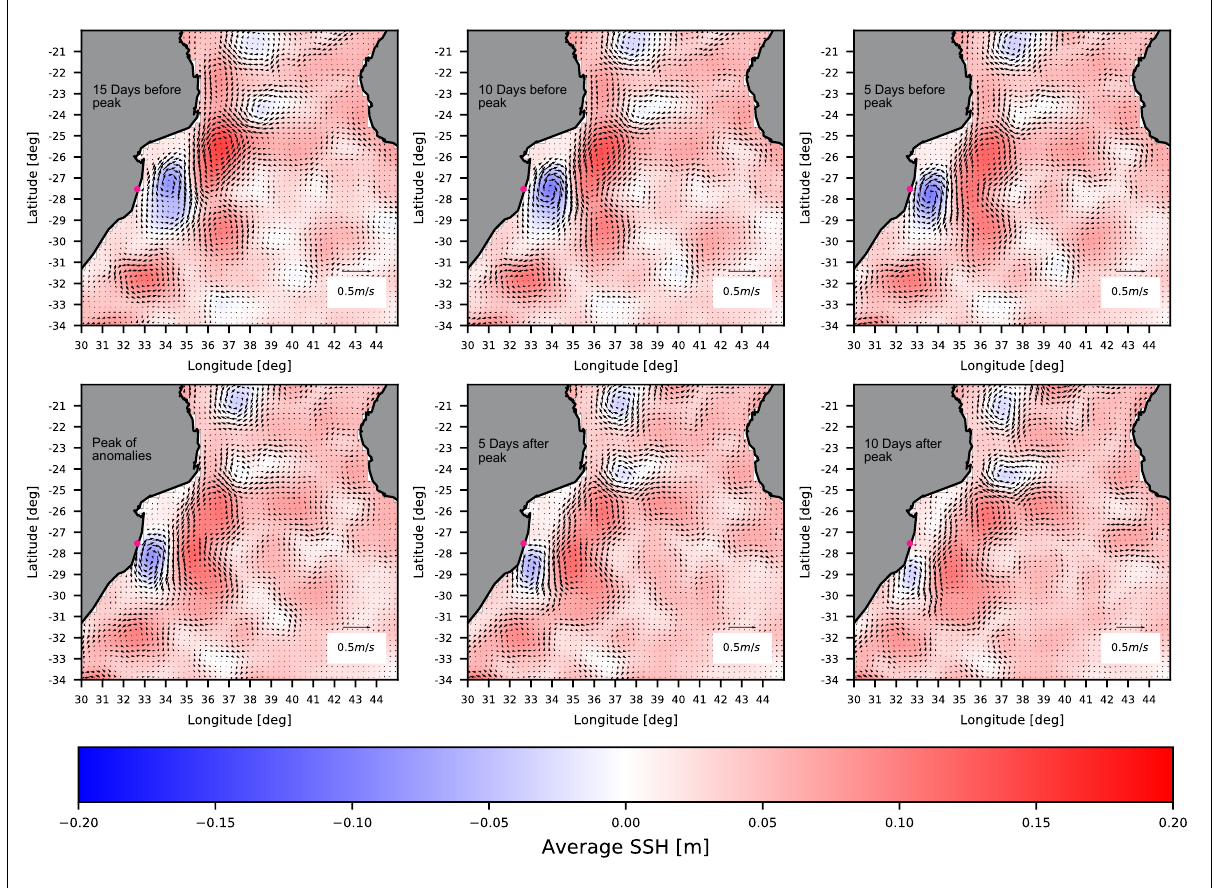
Figure 7: Sea surface height (SSH) and geostrophic current conditional average time lag between 15 days prior and 10 days post peak of the temperature anomalies. Geostrophic currents have been overlaid as a quiver plot and are scaled by